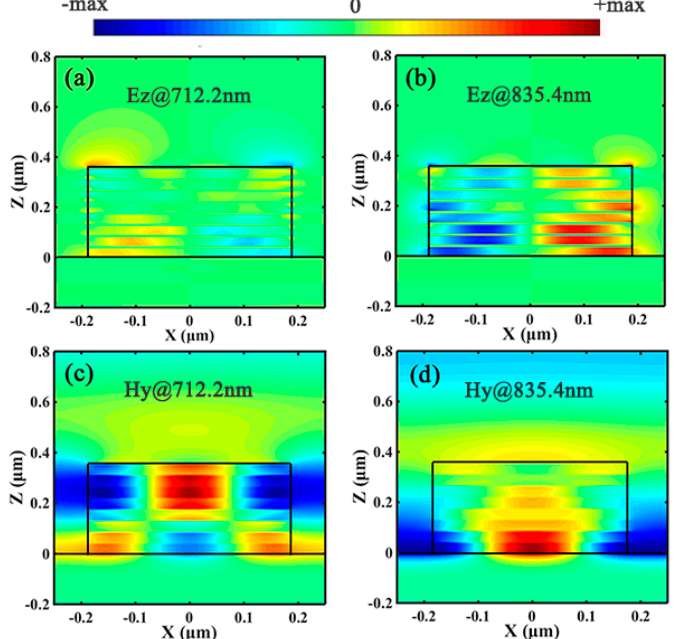
Figure 5. Field distributions of the HRA associated with the absorption peaks. ( a , b ) are the near field distributions of E z at 712.2 nm and 835.4 nm, respectively. ( c , d ) are the near field distributions of H y at 712.2 nm and 835.4 nm, respectively.